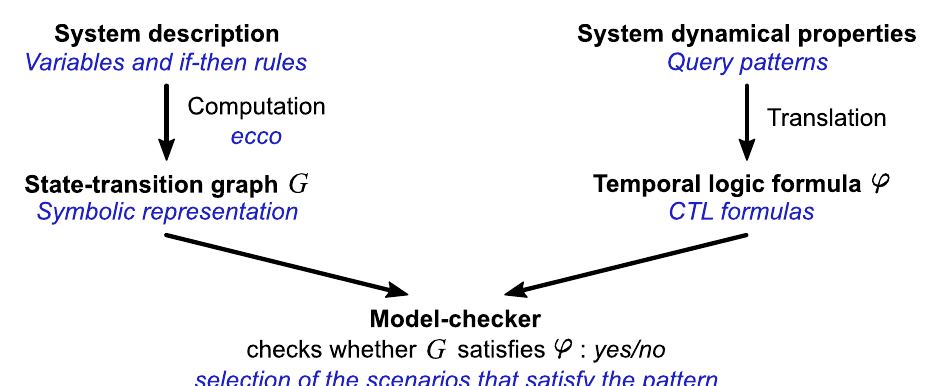
Fig 3. The model-checking methodology. In black the general model-checking outline. In blue italic the implementation described in this article that consists of a particular choice of techniques and tools among the available ones. (Adapted from